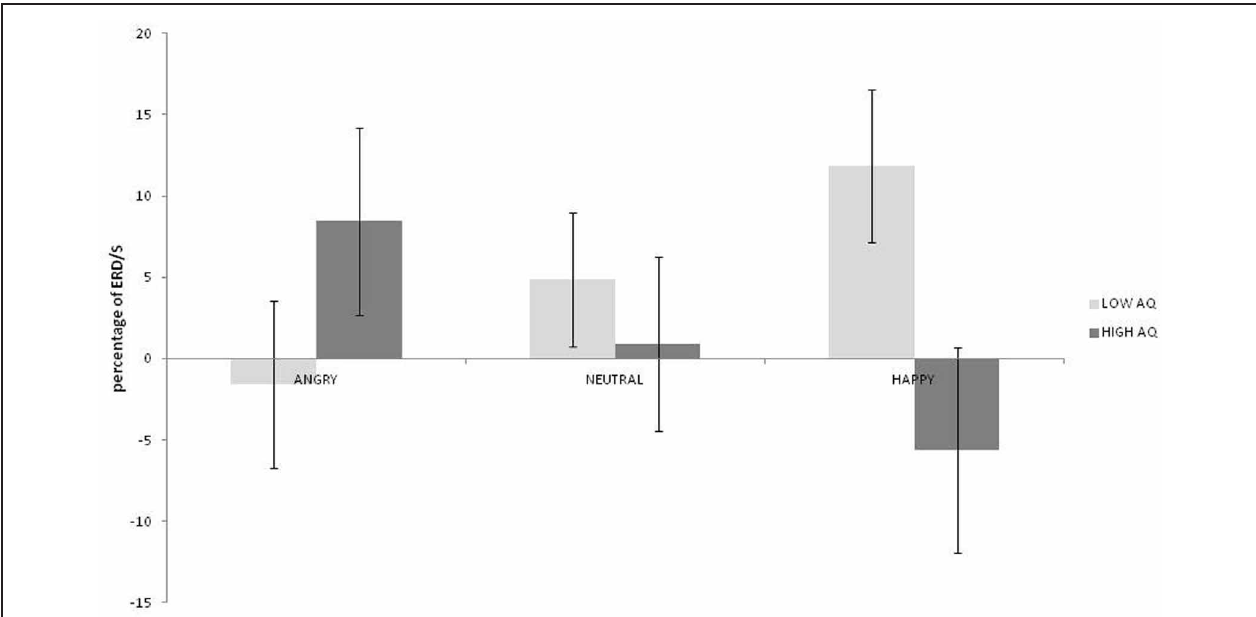
FIGURE 2 | Low beta ERD percentage-change over central sites for low and high AQ groups during angry, neutral, and happy conditions (positive values indicate ERD, negative scores indicate ERS).